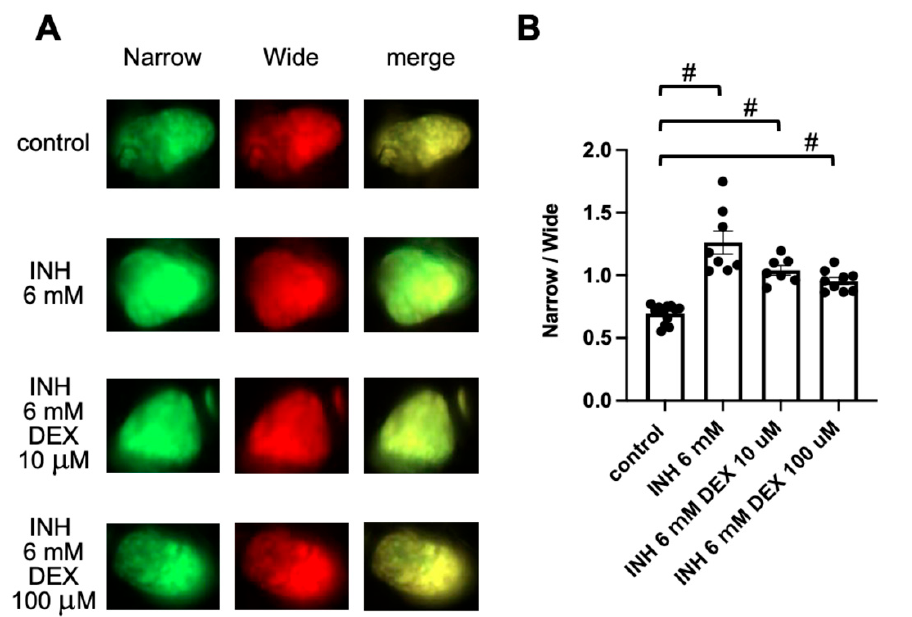
Figure 5. Assessment of hepatic apoptosis in Tg (pck1:Casper3GR) treated with INH with and without DEX. ( A ) Representative in vivo fluorescence images of Tg (pck1:Casper3GR) treated with INH with and without DEX from 4 to 5 dpf. Images acquired using narrow and wide filters and merged images are shown. ( B ) Hepatic apoptosis was assessed as the ratio of narrow and wide areas of fluorescence above the threshold in the liver of zebrafish at 5 dpf treated with INH with and without DEX. Circles represent individual zebrafish, and bars represent the group means with standard error of the means. n = 13, 8, 7, and 9 for control, INH 6 mM, INH 6 mM DEX 10 μ M, and INH 6 mM DEX 100 μ M, respectively. # p < 0.05 vs. control.